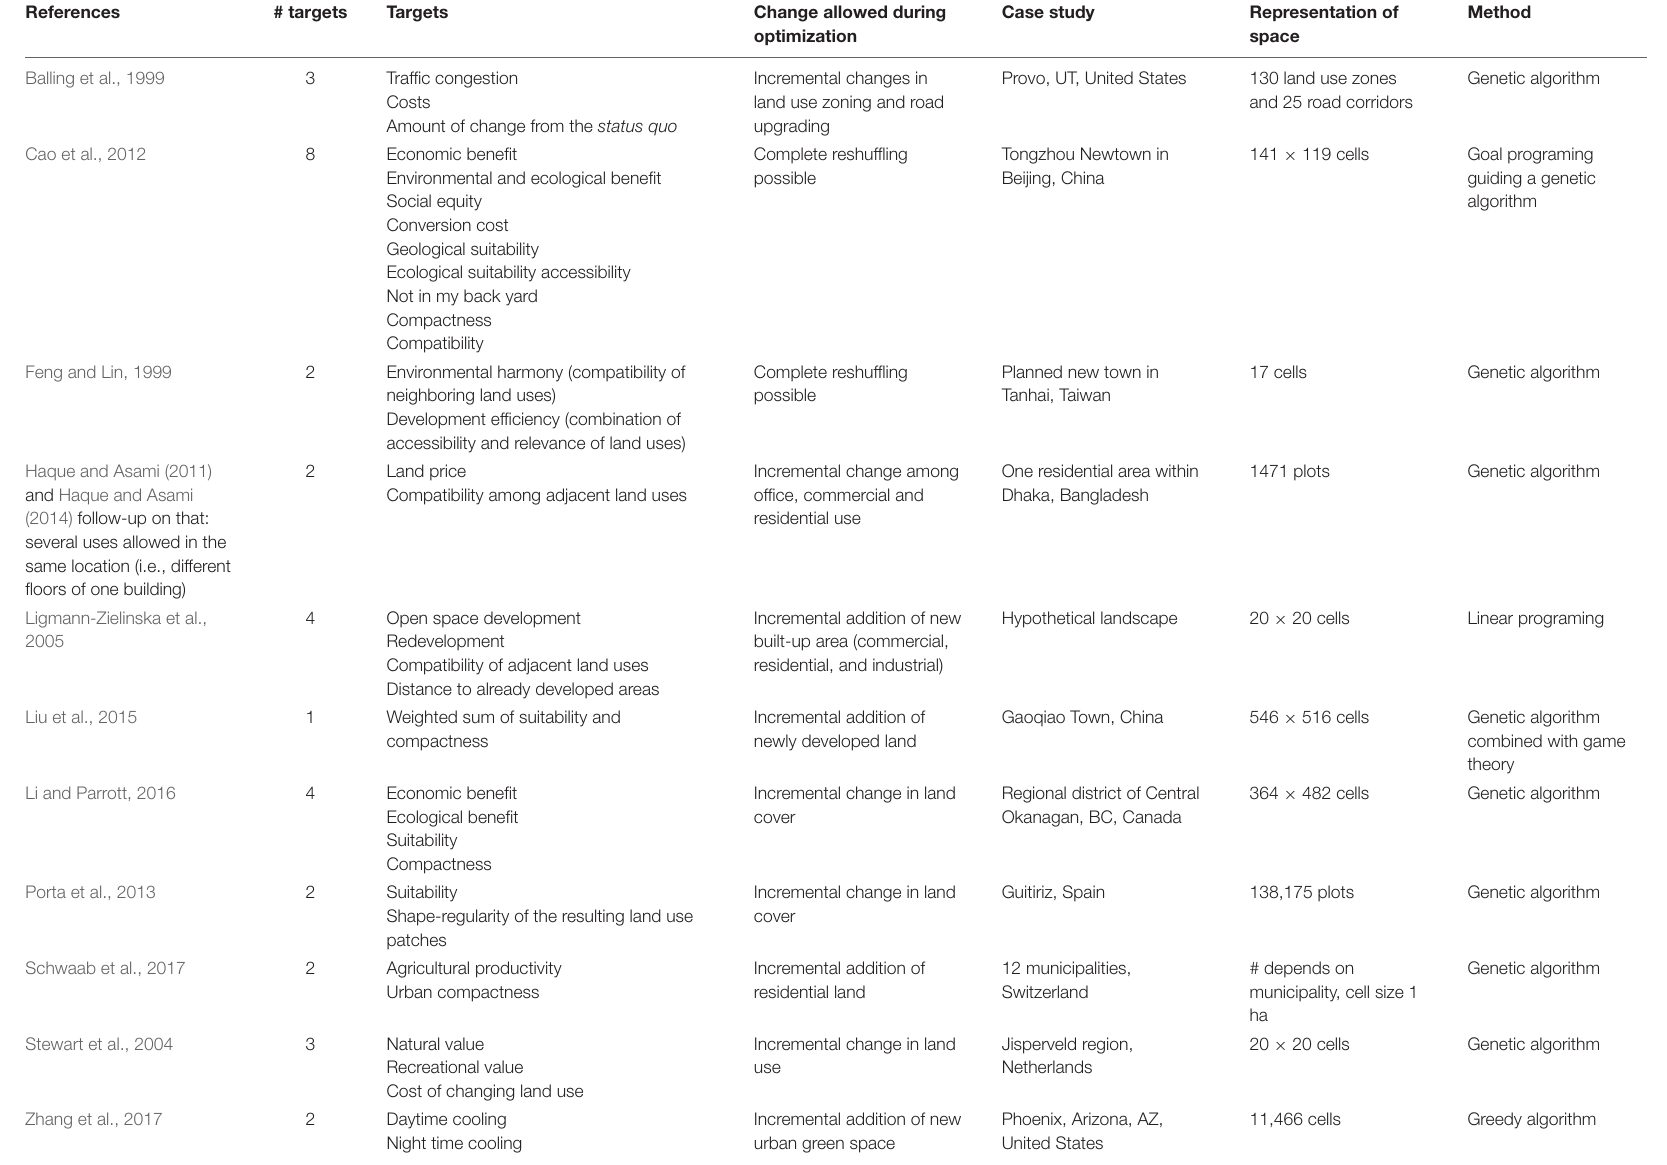
TABLE 2 | Literature review on urban spatial optimization